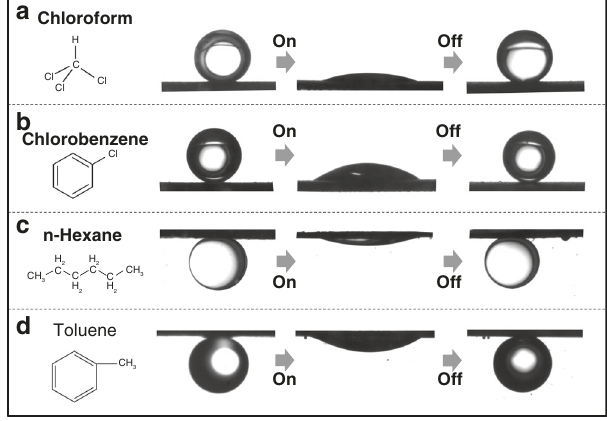
Fig. 4 Generality of the in situ reversible underwater superwetting transition for various oils. Various oils including polar (e.g., toluene, chlorobenzene, and chloroform) and nonpolar (e.g., n-hexane) oils were observed to participate in the in situ reversible superwetting transition, which demonstrates that this in situ reversible superwetting transition can be shared by a range of oils